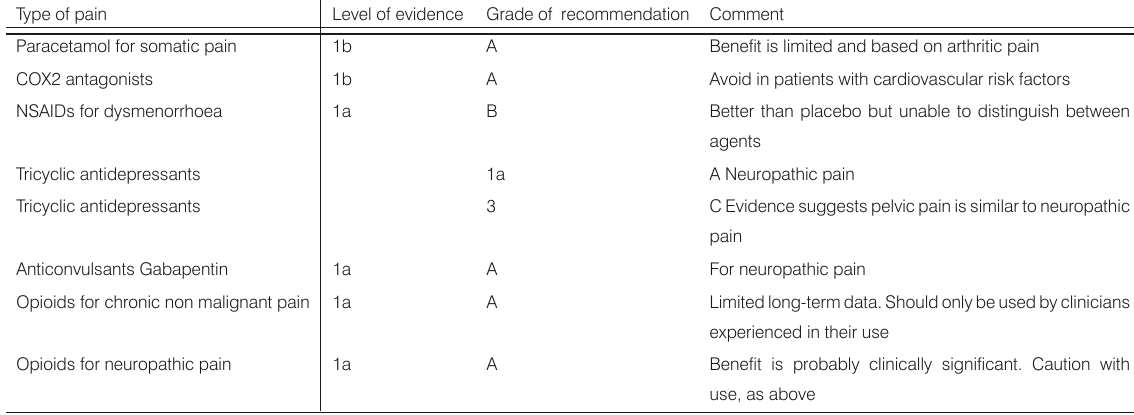
Table 1. General treatment of